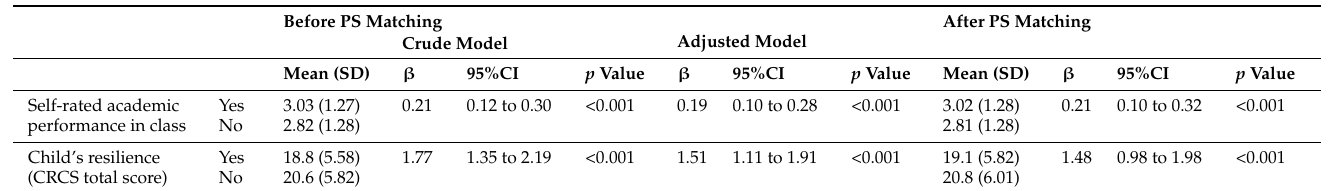
Table 3. Statistical results of academic performance and resilience before and after propensity score